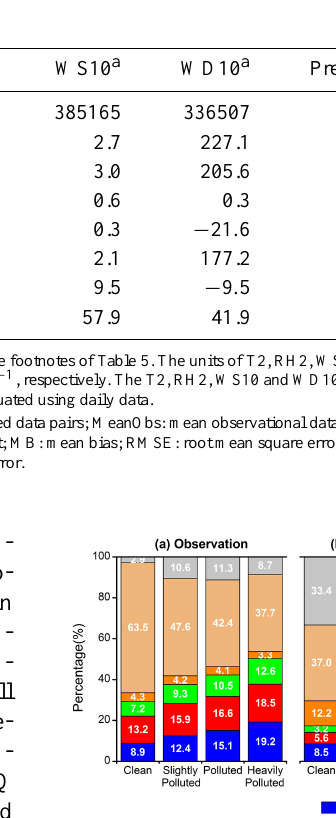
Figure 5. Percentile compositions of major components in PM 2 .